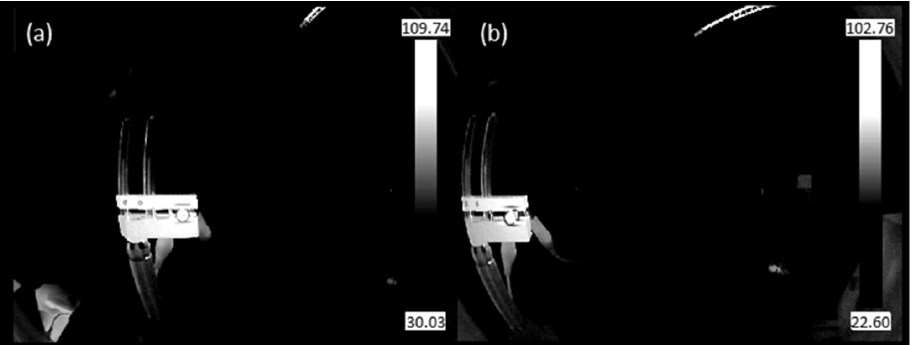
Figure 11. Grayscale thermal image of a mounted LED, heating up a metal plate after background correction: ( a ) on-axis positioning, ( b ) off-axis positioning (at 164°). These images were used as in- correction: ( a ) on-axis positioning, ( b ) off-axis positioning (at 164 ◦ ). These images were used as puts for the MTF calculation. inputs for the MTF